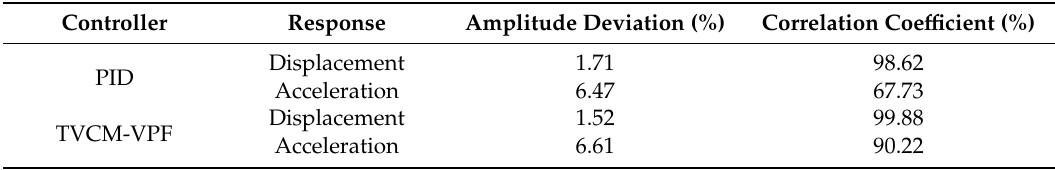
Figure 8. Shaking table substructure testing (STST) results with conventional proportional integral derivative (PID) control. Table 3. Error comparison of earthquake wave excitation